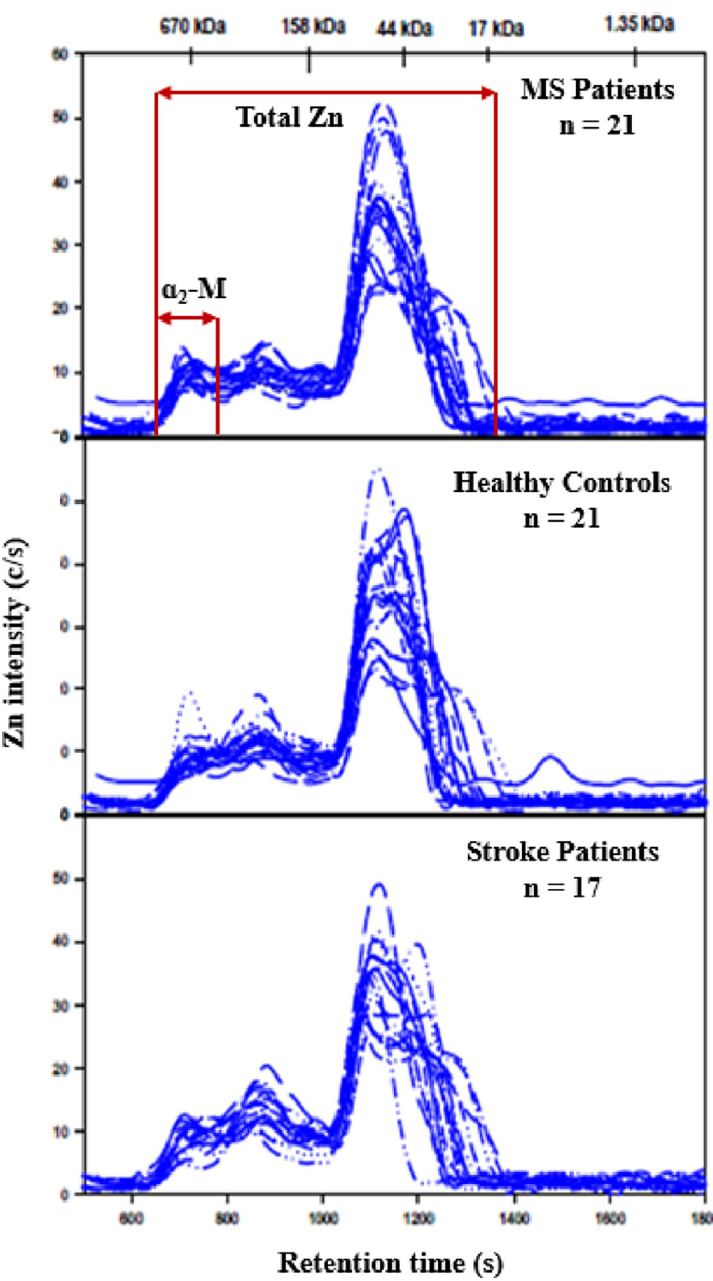
Fig 5. Zn-specific chromatograms obtained after the analysis of plasma from MS participants, AIS participants and healthy controls. Column: Superdex 200 Increase 10/300 GL (30 x 1.0 cm I.D., 8 μ m particle size), Temperature: 22˚C, Mobile phase: 150 mM PBS buffer (pH 7.4), Flow rate: 0.75 mL/min, Injection volume: 500 μ L. ICP-AES detection at 213.86 nm (Zn). Retention times of molecular weight markers are depicted on top. 750 μ L of plasma was diluted with 250 μ L of PBS buffer and 500 μ L of the obtained solution were injected on the SEC column. AIS and MS participants and age matched healthy controls for Fe, Cu and Zn metalloproteins. While we did not observe statistically significant differences between the obtained average Cu, Zn and Fe peak areas corresponding to Cp, α M, Tf and a Hp-Hb complex between the 2